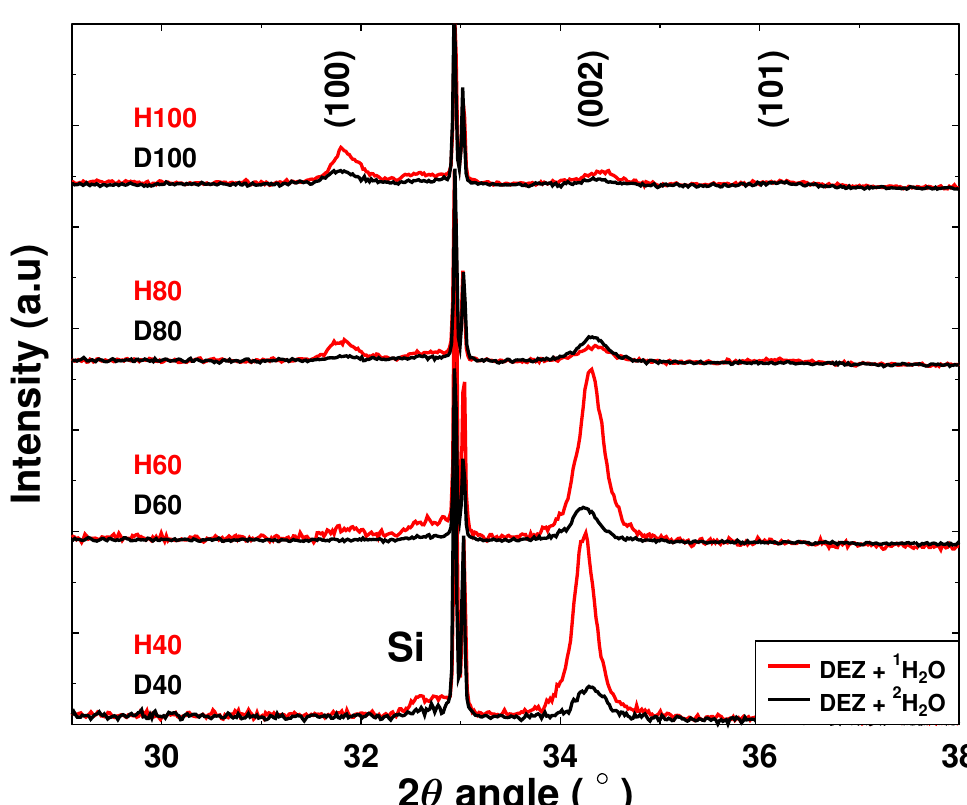
Figure 2. XRD patterns of selected ZnO films deposited at different temperatures with both 1 H 2 O (red) and 2 H 2 O (black). Films deposited with 2 H 2 O are thinner than the films deposited with 1 H 2 O, which affects the peak intensity. The double peak at 33 ◦ originates from the silicon substrate.